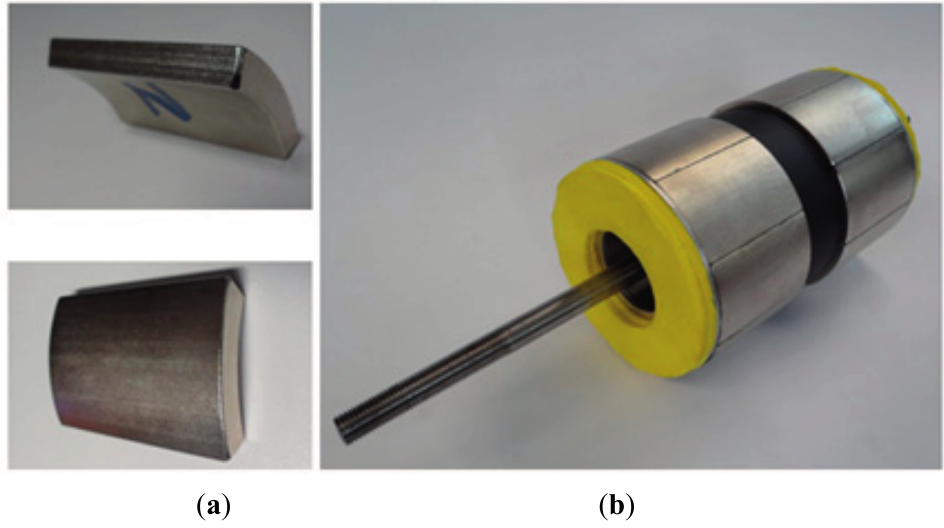
Figure 3. Picture of ( a ) a 45° segment of magnet with parallel magnetization employed to build the prototype and ( b ) the mover of the prototype built with two poles of eight segments of permanent magnets with parallel